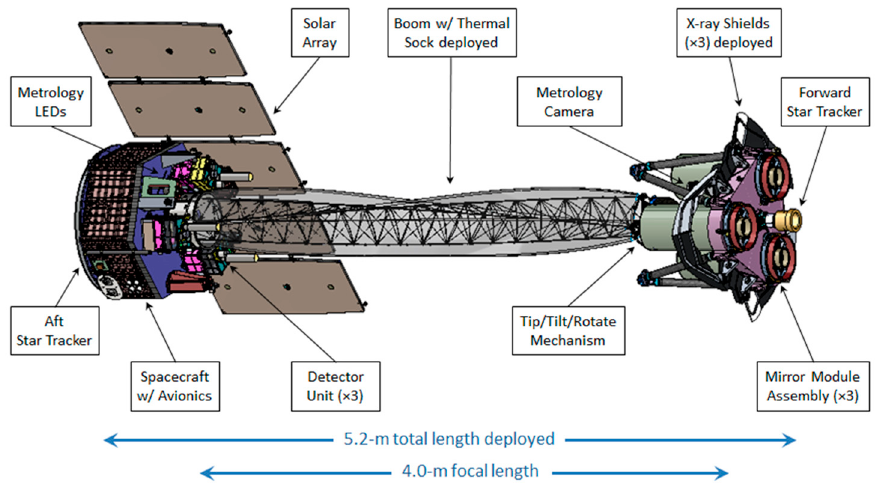
Figure 11. Schematic rendering of IXPE deployed with the major elements identified.